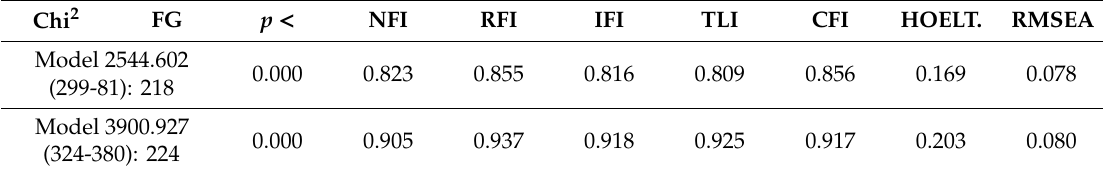
Table 9. Models of structural linear results of the